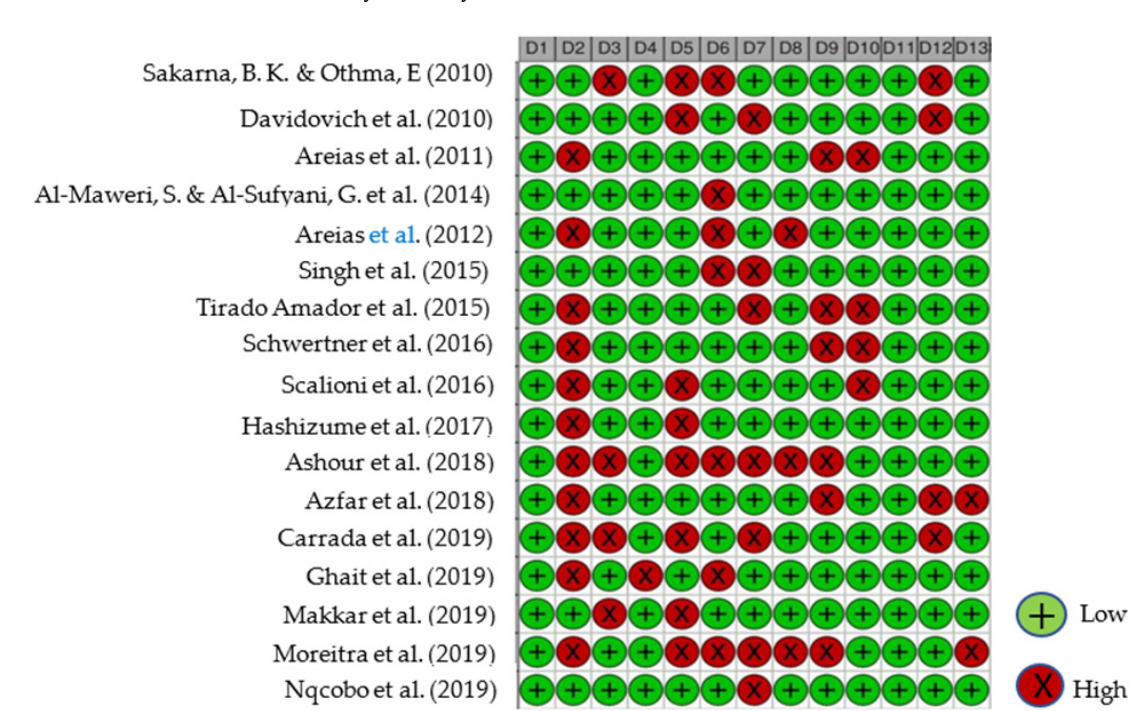
Figure 2. Studies Traffic light risk of bias plot. D1—Population representativeness; D2—Target population; D3—DS group; D4—Control group; D5—Data collection in the same way; D6—Data